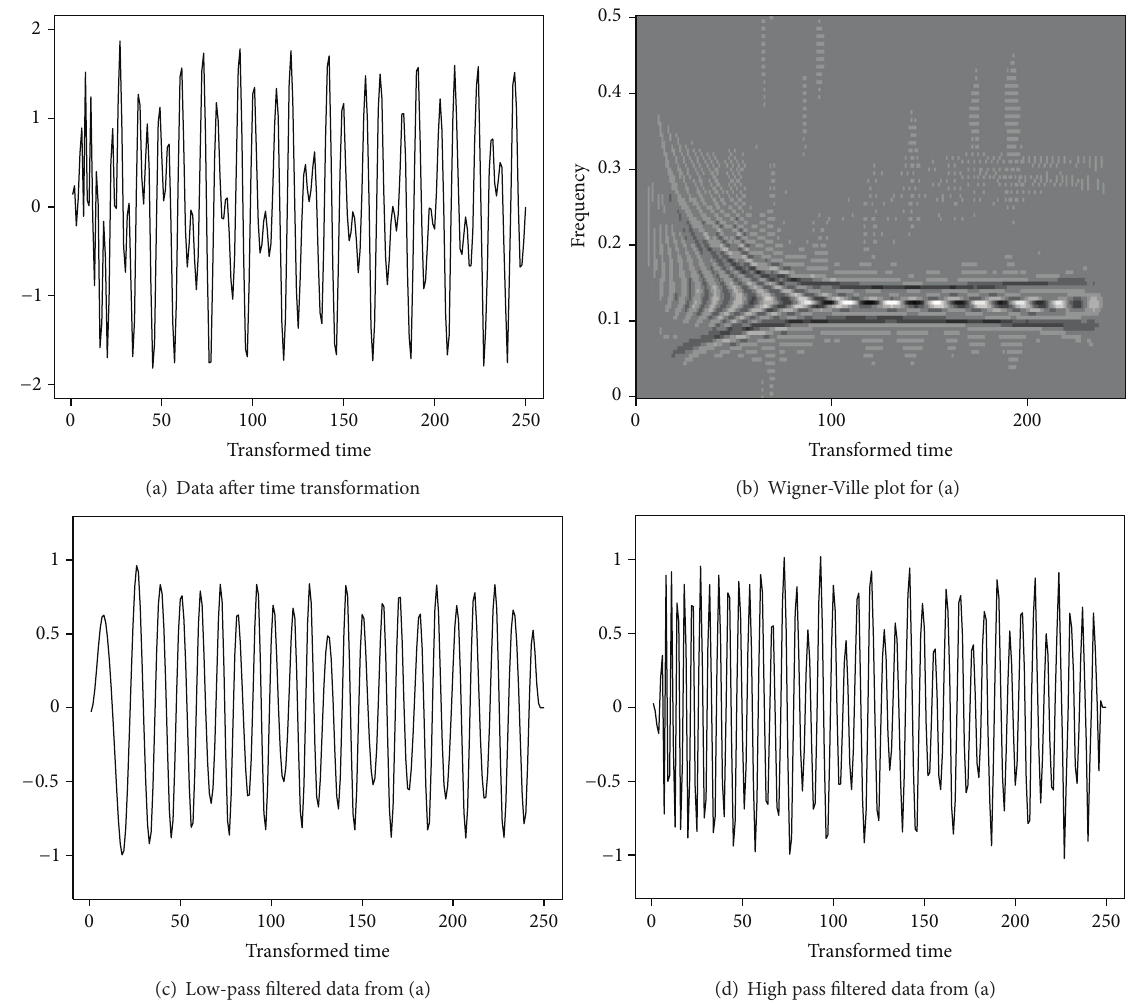
Figure 5: (a) Data on transformed time axis; (b) the Wigner-Ville time-frequency distribution of (a); (c) data in (a) after low-pass filter; (d) data in (a) after high-pass